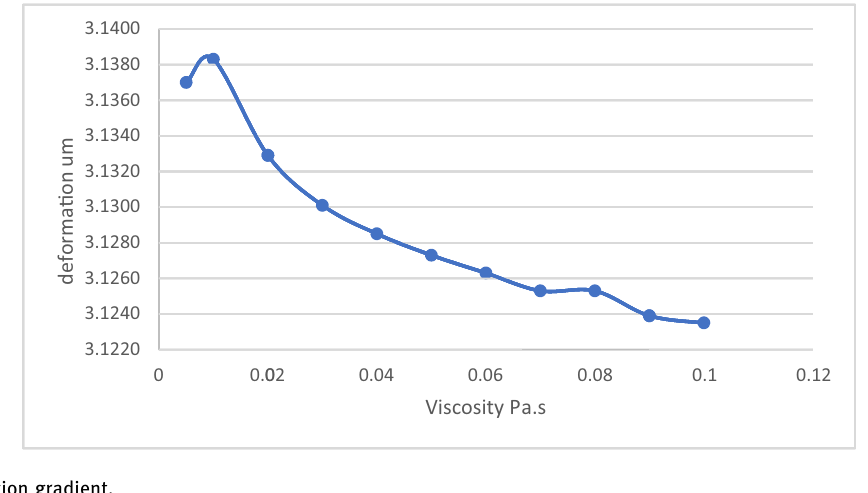
Figure 6: Deformation